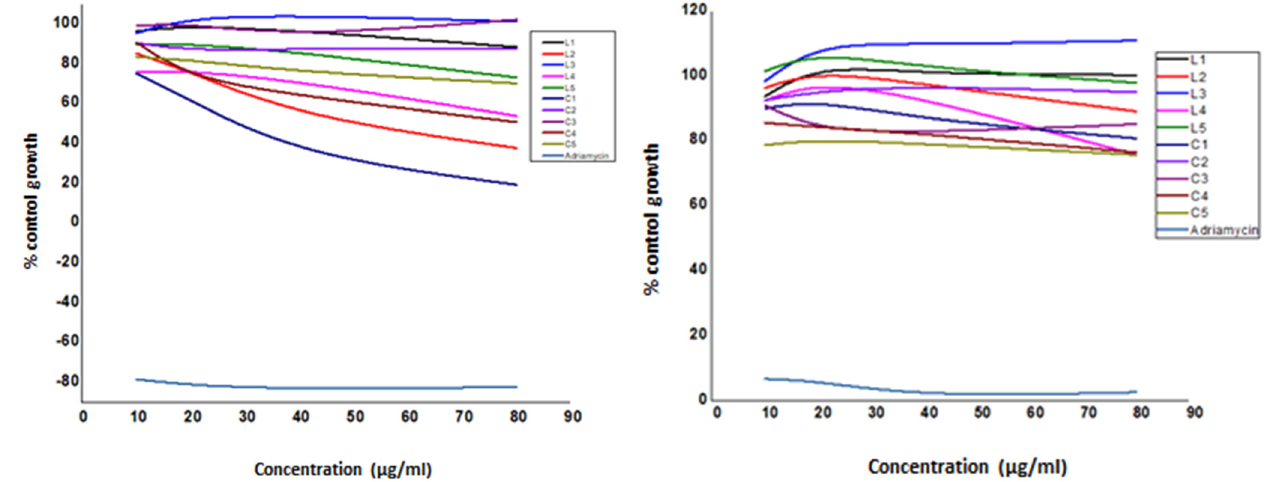
Figure 7. The growth curves of human breast cancer cell line MCF-7 ( left ) and human lung cancer cell line A-549 ( right ) of Schiff bases and their Co(II) complexes. Table 9. Average values for % control growth for the cell line MCF-7.